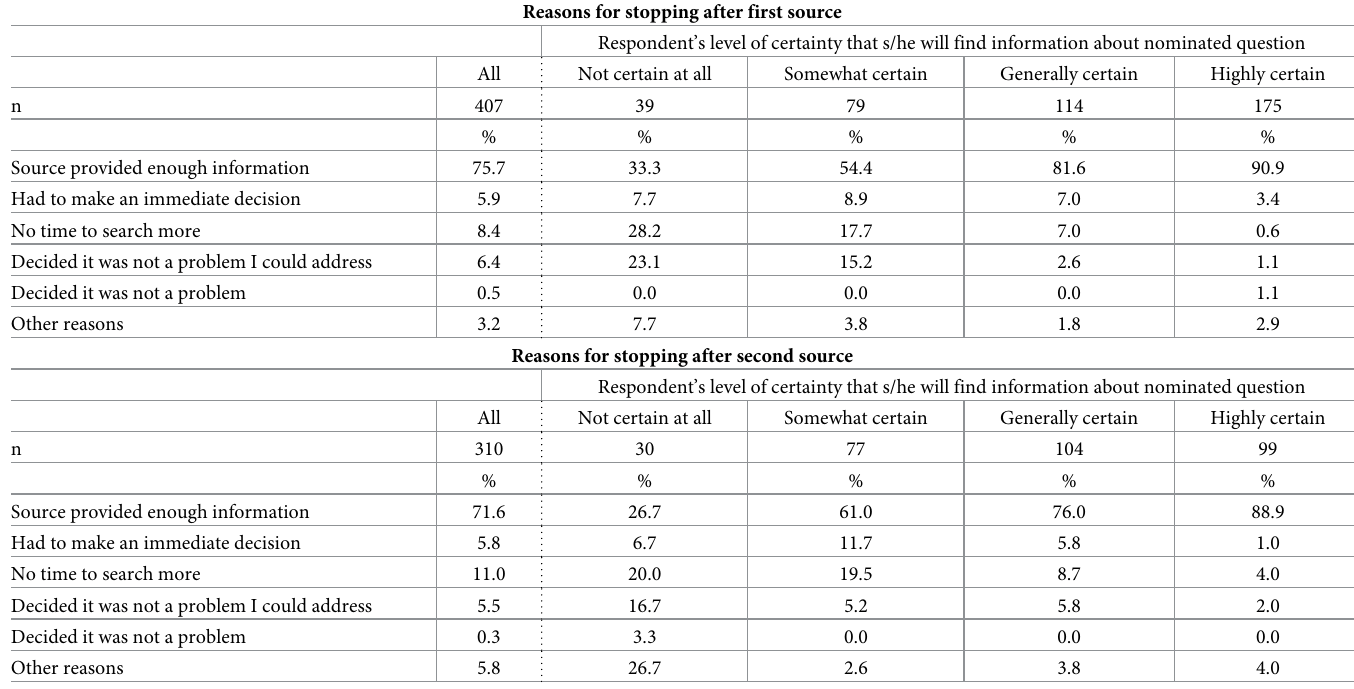
Table 6. Reasons for stopping by respondent certainty of finding